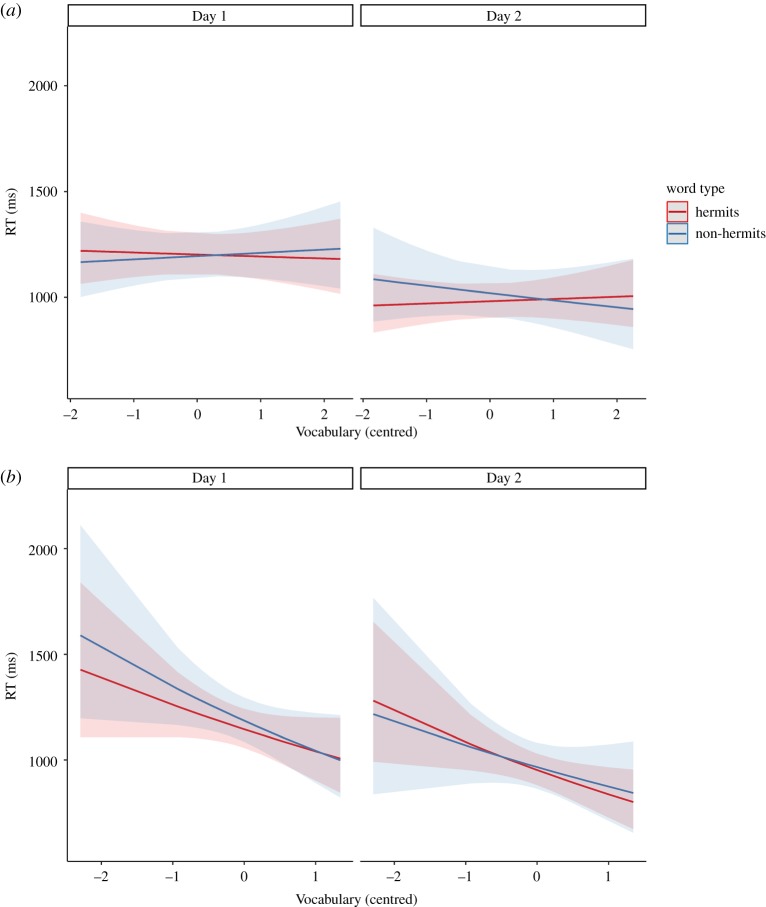
Semantic categorization back-transformed RT (ms) correlated with Vocabulary (scaled and centred) for both Day 1 and Day 2 for (a) the short delay group and (b) the long delay group.